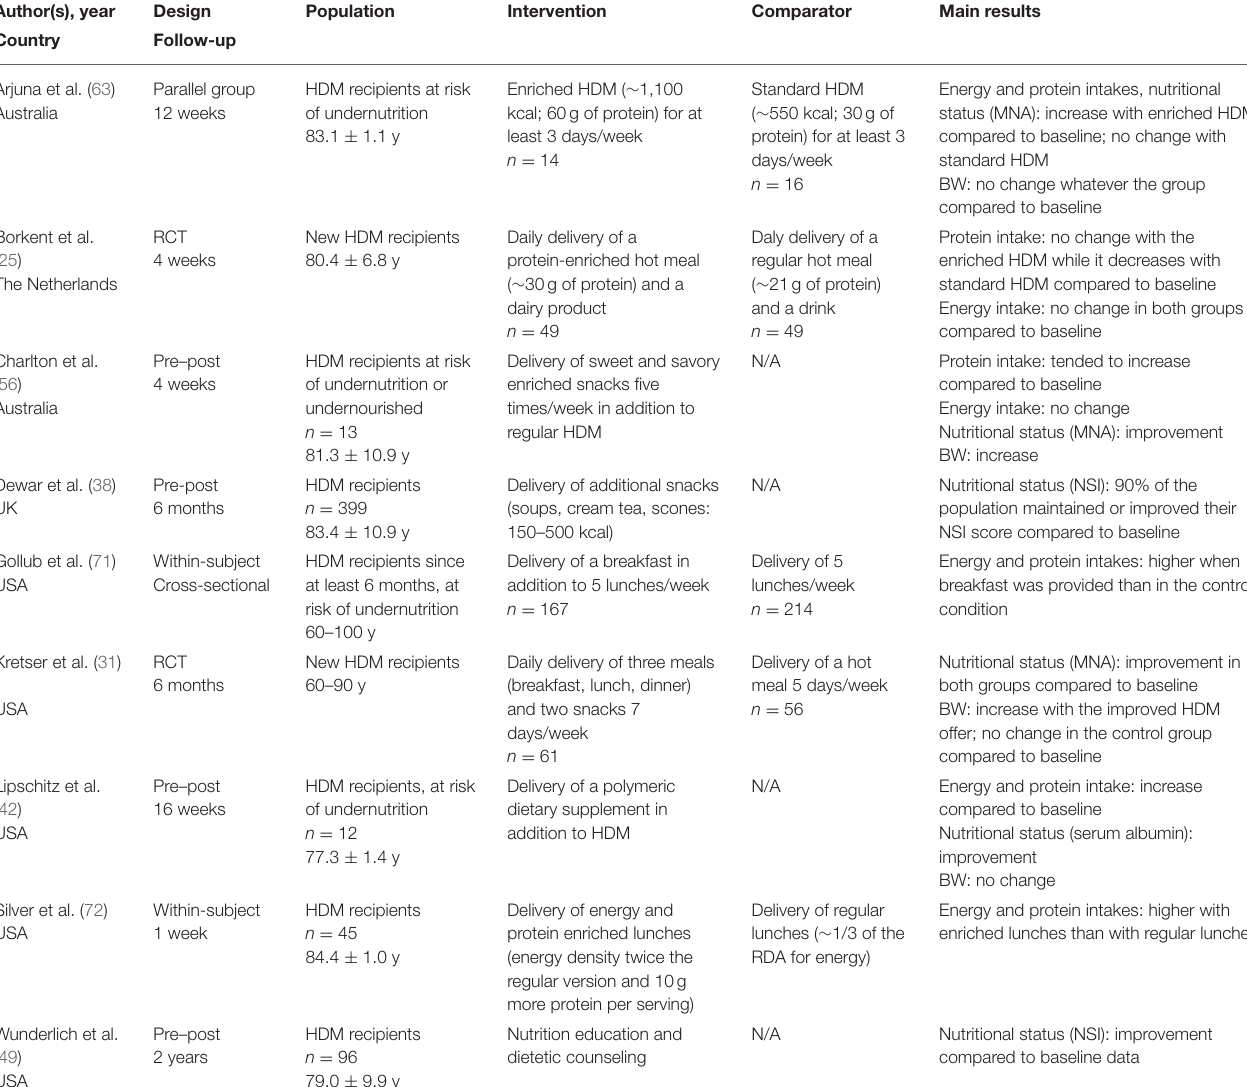
TABLE 5 | Impact of an improved HDM service on nutritional outcome compared to a regular